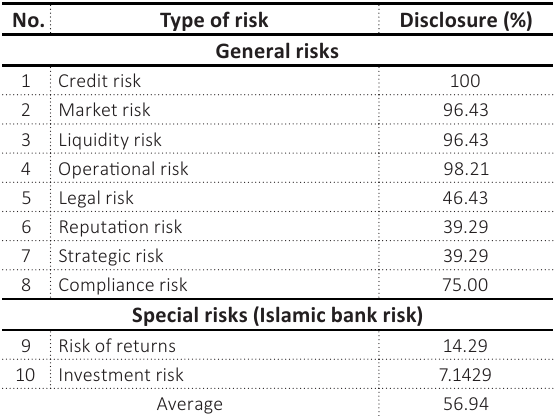
Table 1. Risk disclosure by Islamic banks